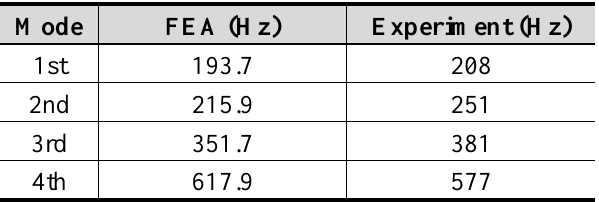
Table 3. Natural frequencies of the underwater cylindrical shell obtained by FEA and experiment.